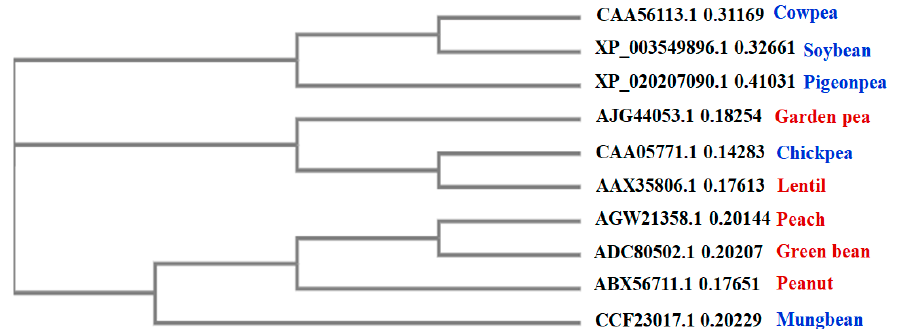
Figure 2. Phylogenetic tree drawn by Clustal Omega MSA tool for evaluating the evolutionary relatedness among LTPs from different legumes and peach. In red are known allergenic LTPs, while in blue are query proteins to be evaluated for potential allergenicity. The tree was drawn by neighbor-joining (NJ) algorithm without distance corrections.